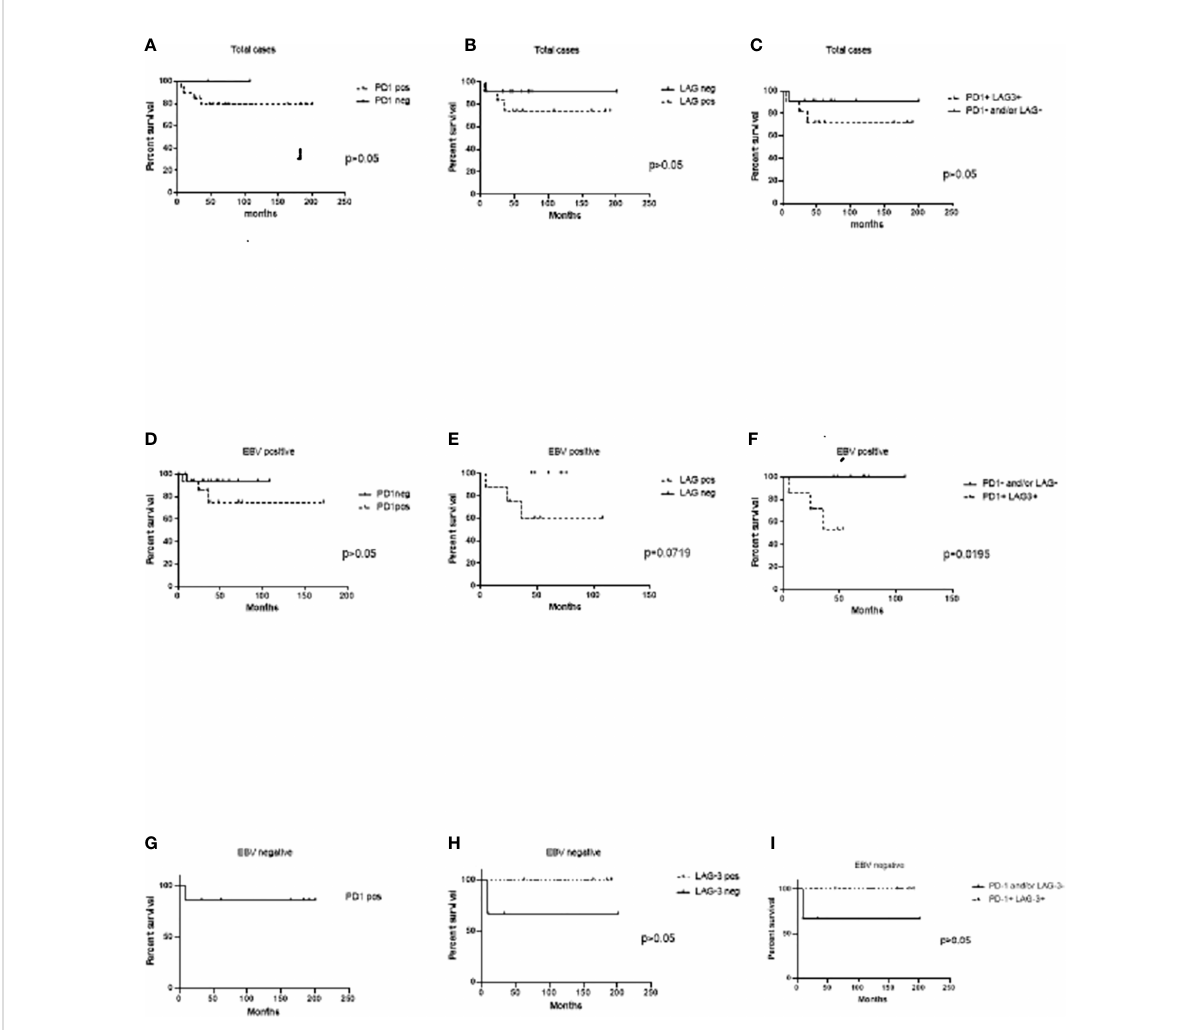
FIGURE 2 Event-free survival (EFS) analysis to PD-1 and LAG-3 expression at the microenvironment. (A) Cases expressing PD-1+cells at the microenvironment versus PD-1- ones in the whole series. (B) Cases expressing LAG-3+ at the microenvironment versus LAG-3-ones in the whole series. (C) Cases expressing both PD-1+/LAG-3+ cells at the microenvironment versus PD-1- and/or LAG-3 ones in the whole series. (D) EBV+ cases expressing PD-1 +cells at the microenvironment versus PD-1- ones. (E) EBV+ cases expressing LAG-3+ at the microenvironment versus LAG-3- ones. (F) EBV+ cases expressing both PD-1+/LAG-3+ cells at the microenvironment versus PD-1- and/or LAG-3 ones. (G) EBV- cases expressing PD-1+ cells at the microenvironment versus PD-1- ones. (H) EBV- cases expressing LAG-3+ at the microenvironment versus LAG-3- ones. (I) EBV- cases expressing both PD-1+/LAG-3+ cells at the microenvironment versus PD-1- and/or LAG-3